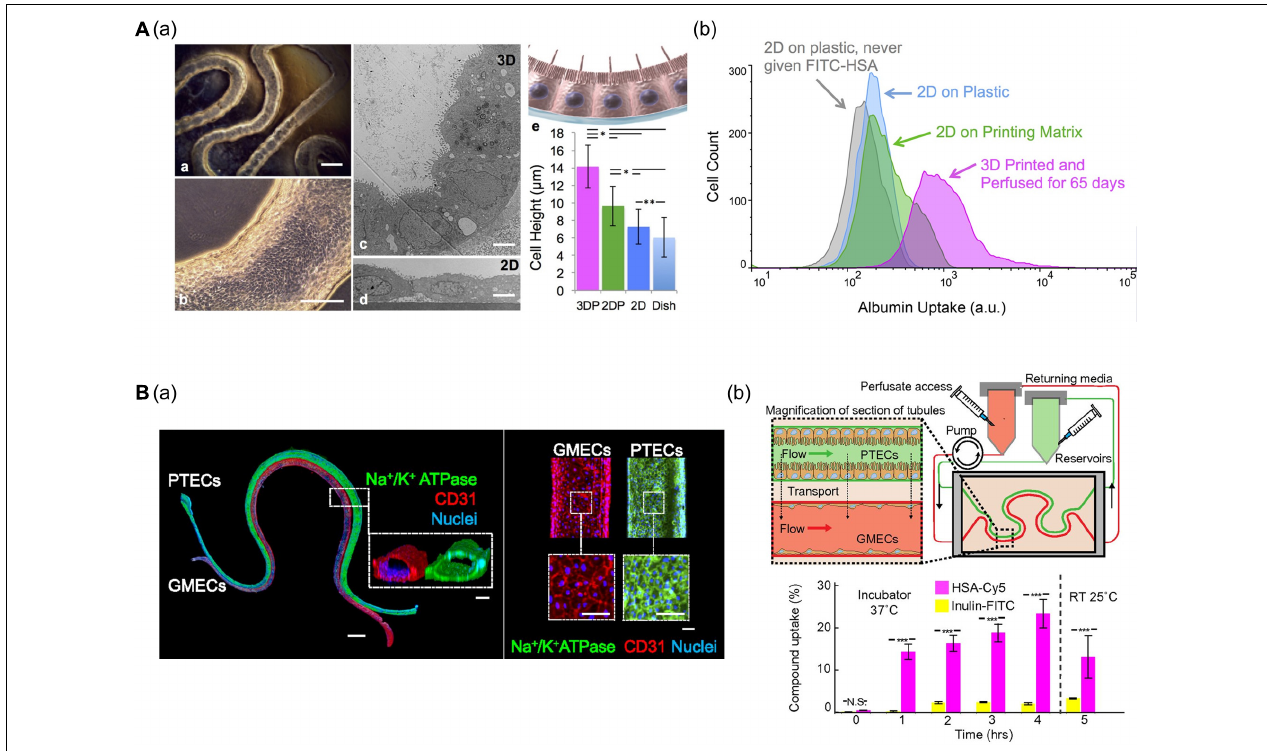
FIGURE 4 | (A) Characteristics of 3D bioprinted convoluted renal proximal tubule structure. (a) Phase contrast and TEM images of printed proximal tubule models and enhanced cell height in 3D proximal tubule model. (b) Flow cytometry data demonstrated increased albumin uptake compared to 2D conditions (* p < 0.001; ** p < 0.02). Reprinted with permission from Homan et al. (2016). (B) 3D renal proximal tubule with glomerular microvascular channels. (a) Whole-mount immunofluorescence images show the co-localized epithelium and endothelium with a distance of approximately 70 µ m. (b) Schematic depicts a